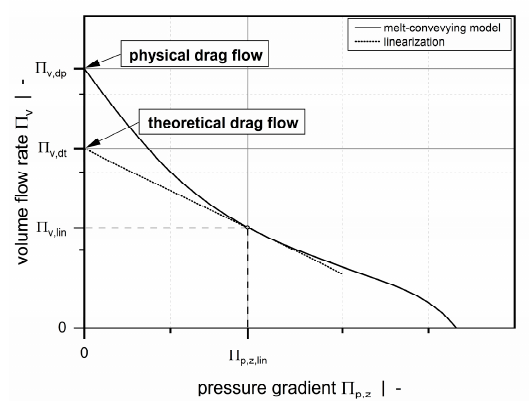
(cid:16) (cid:17) (cid:12) (cid:12) Π . (cid:12) Π V p , z